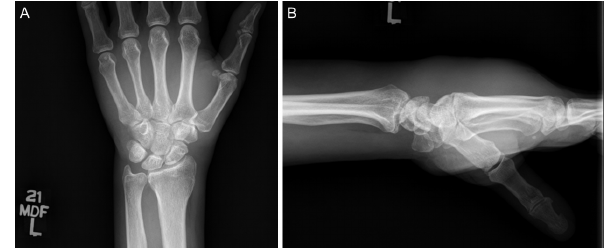
Figure 6. (a) AP and (b) lateral radiographs of the patient’s left wrist and hand demonstrate no osseous changes secondary to os- teomyelitis. Significant edema can be appreciated in the soft tissues of the hand and wrist on lateral imaging.